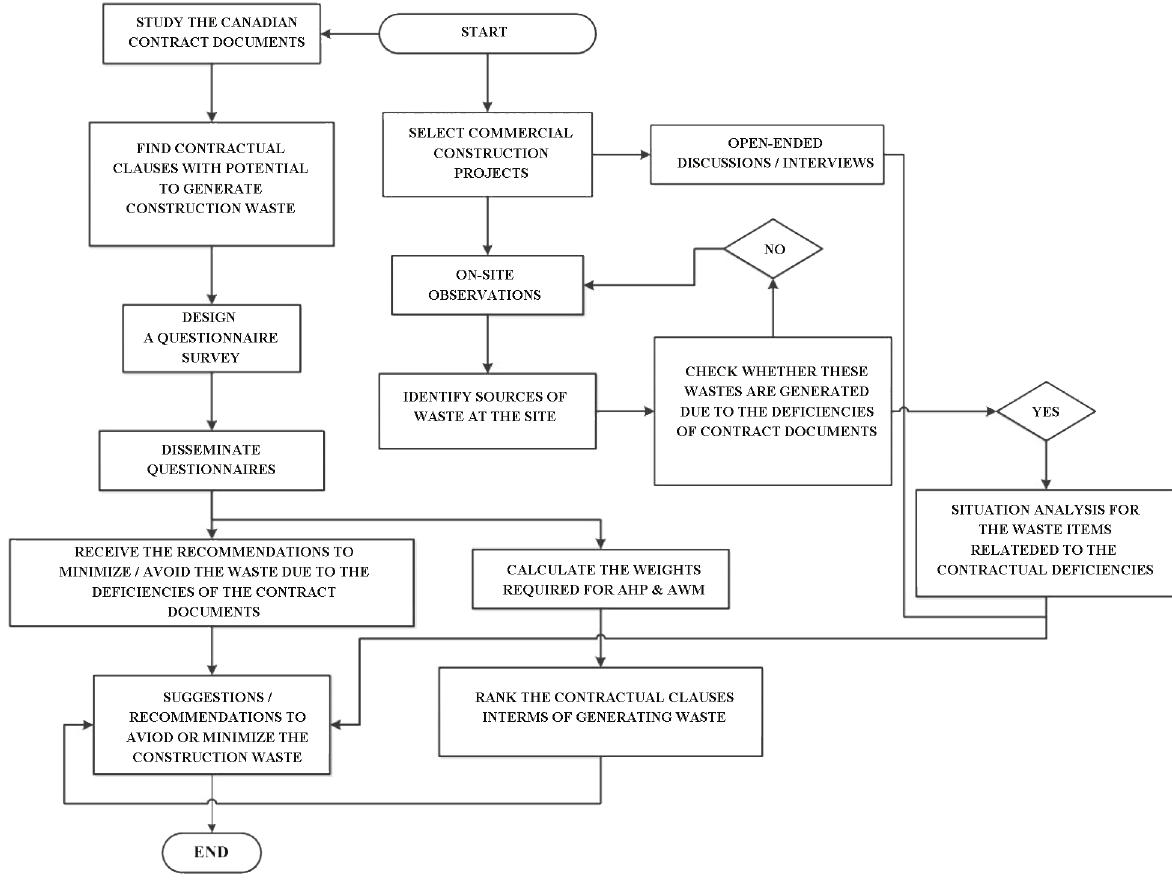
Fig. 1. Theoretical framework